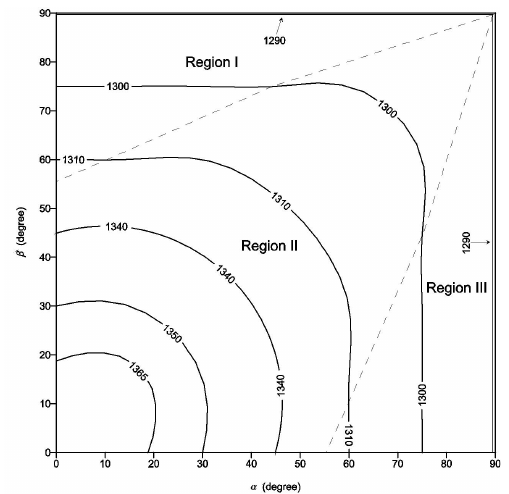
Fig. 5. Contours for the time for reaching quasi-steady state SDR for κ y = 1, κ z = 1, x 0 D = 4, L D = 1, and various orientation α and inclination β .